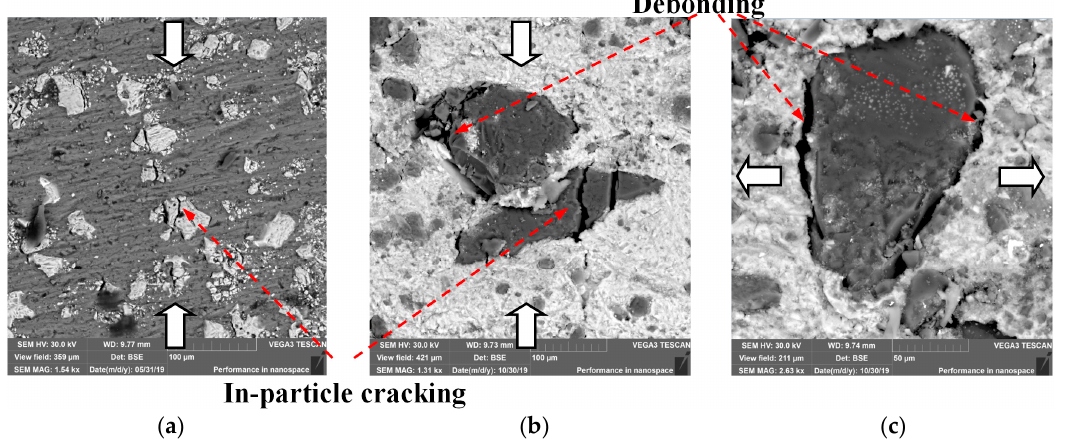
Figure 4. Fracture pa tt erns under compression ( a , b ) or tension ( c ) or of the Al-TiC ( a ) and Al-B 4 C composites ( b , c ). composites ( b , c